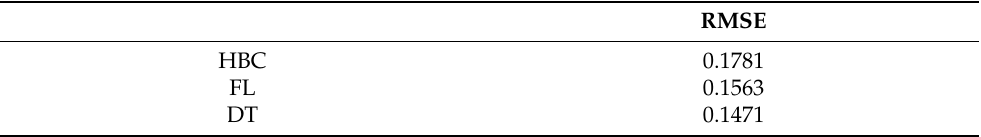
Table 1. Root Medium Square Error (RMSE) (voltage of the network) with different models applied to the IEE 69-bus distribution